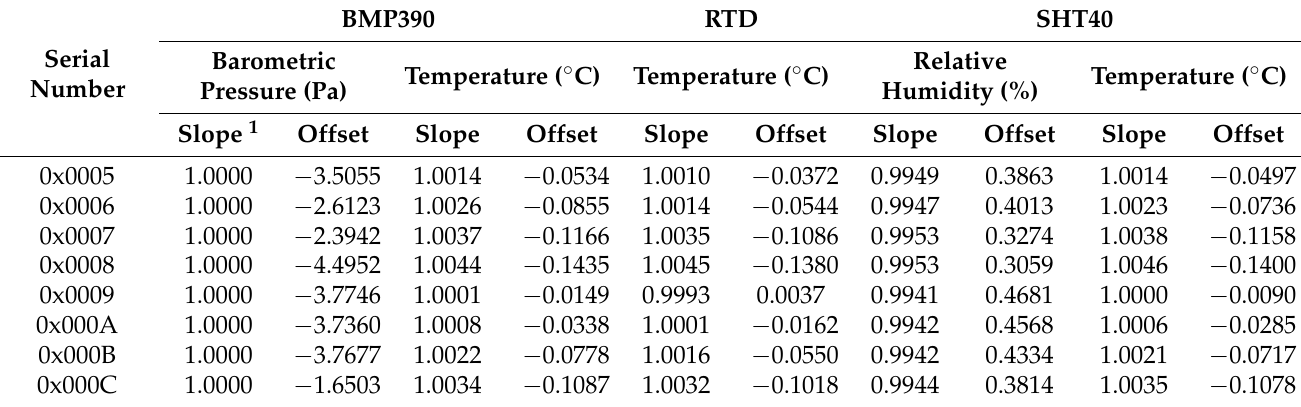
Table 10. Regression model coefficients for calibrated PTH probes.